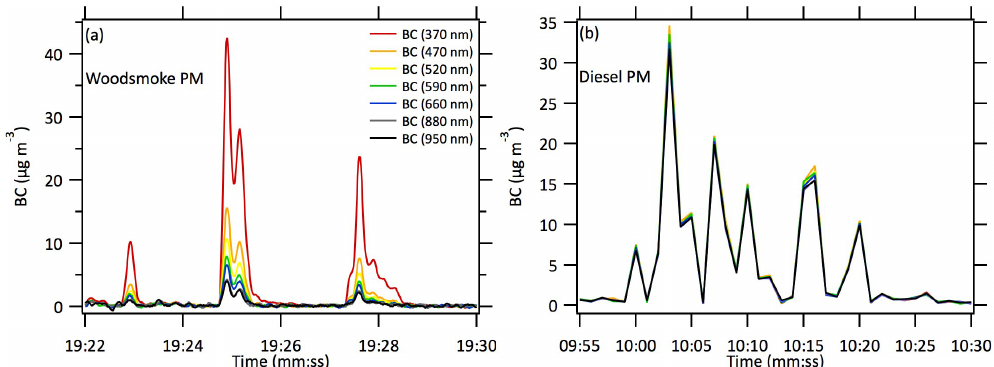
Figure 1. Wavelength-dependent responses of the AE-33 Aethalometer to (a) woodsmoke and (b) diesel plumes. Note that the purpose of this figure is to reveal the qualitative differences rather than making a quantitative comparison between the two types of